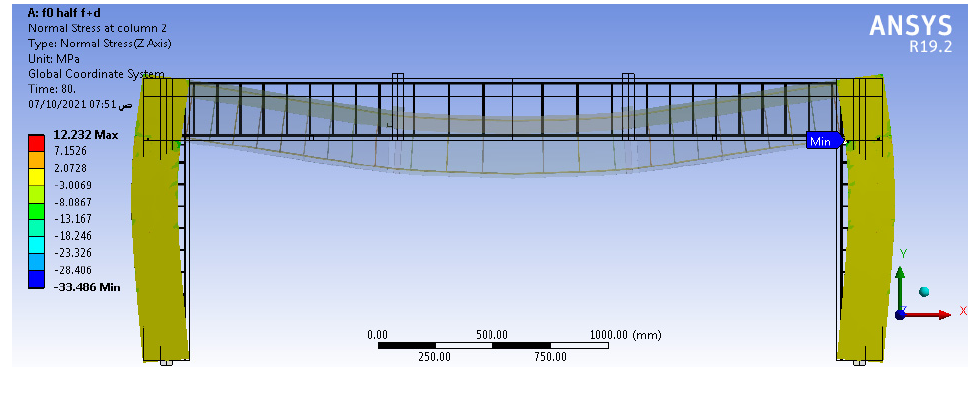
Figure 18. Normal stress of columns for F 0 .